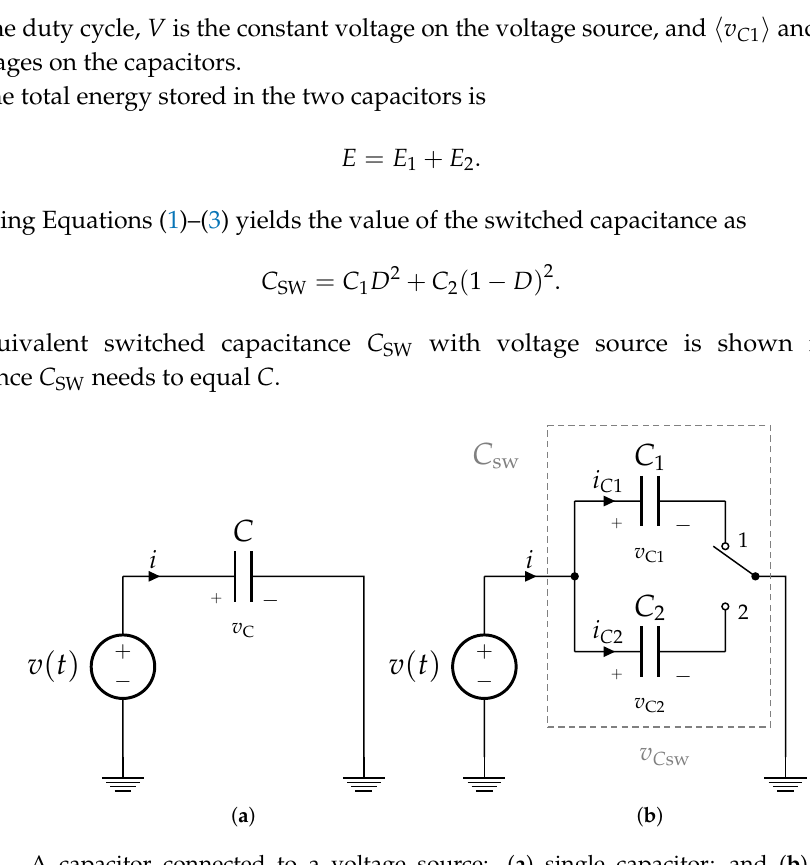
Figure 3. A capacitor connected to a voltage source: ( a ) single capacitor; and ( b ) switched capacitor